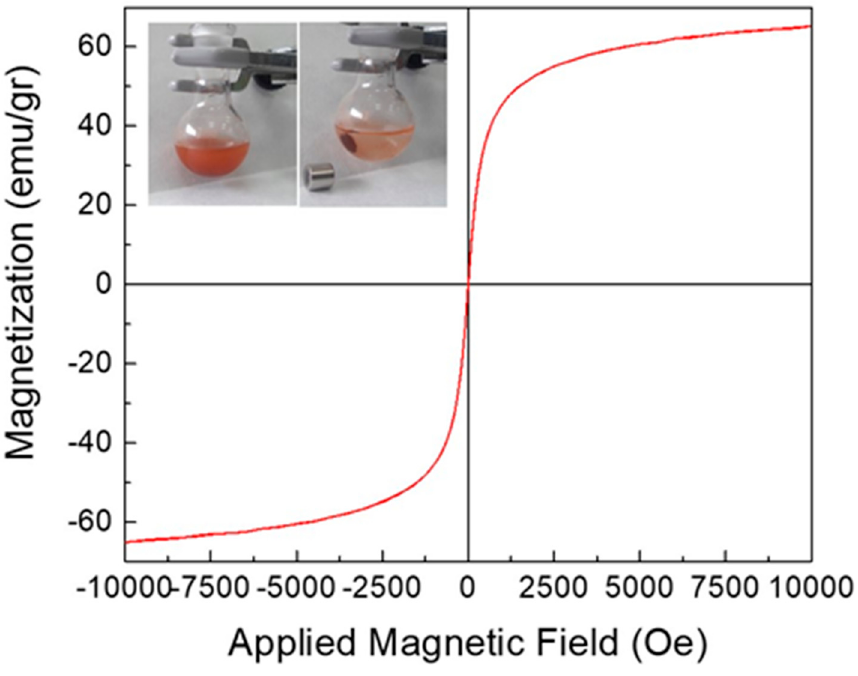
Figure 3. Magnetic curves of γ -Fe 2 O 3 /SiO 2 -STZ. Inset: Left, reaction mixture containing γ -Fe 2 O 3 /SiO 2 - STZ. Right, γ -Fe 2 O 3 /SiO 2 -STZ collected by using an external magnet after the reaction. Table 2. Results of the oxidation of benzyl alcohol.